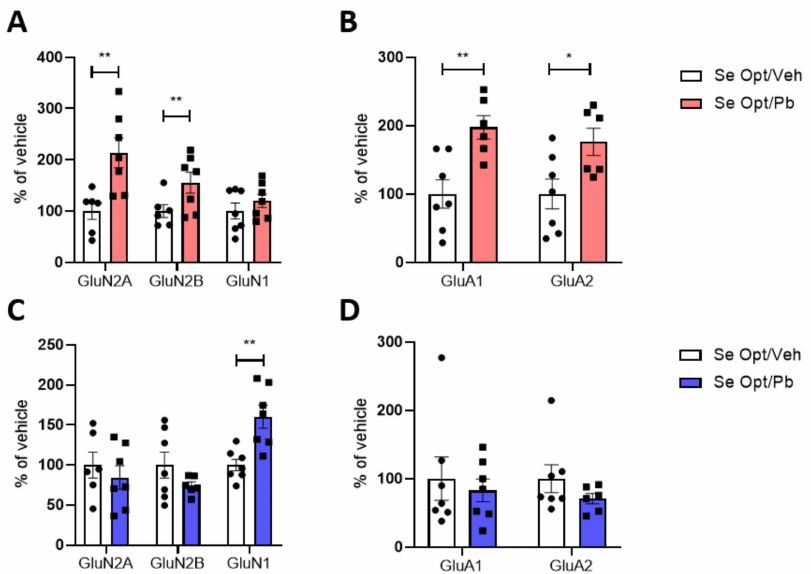
Figure 7. Sex differences in the post-synaptic trafficking of glutamatergic receptors in juvenile rats fed with optimal Se diet and exposed to Pb. Expression of NMDA and AMPA receptors in TIF of PND 23 hippocampi of female ( A , B ) and male ( C , D ) rats fed with optimal Se diet and exposed to ~1.25 mg/kg body weight Pb per day. Data were normalized on actin levels. Data are shown as individual value plots and are represented as % of vehicle ( n ≥ 6); Unpaired t -test, * p < 0.05, ** p <